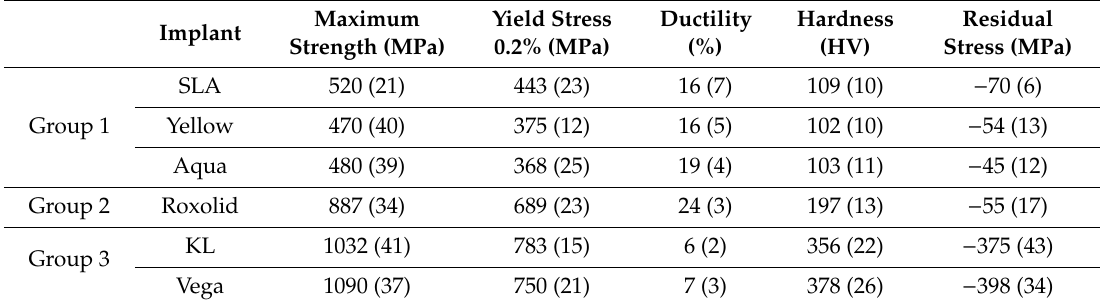
Table 2. Mechanical properties of the dental implants studied include maximum strength and yield stress at 0.2%, expressed in megapascal (MPa), ductility is in percentages, the hardness is expressed in Vickers hardness number (HV) and residual stress in megapascal (MPa). The negative values of the residual stress represent the compressive nature of the stress. Standard deviation between